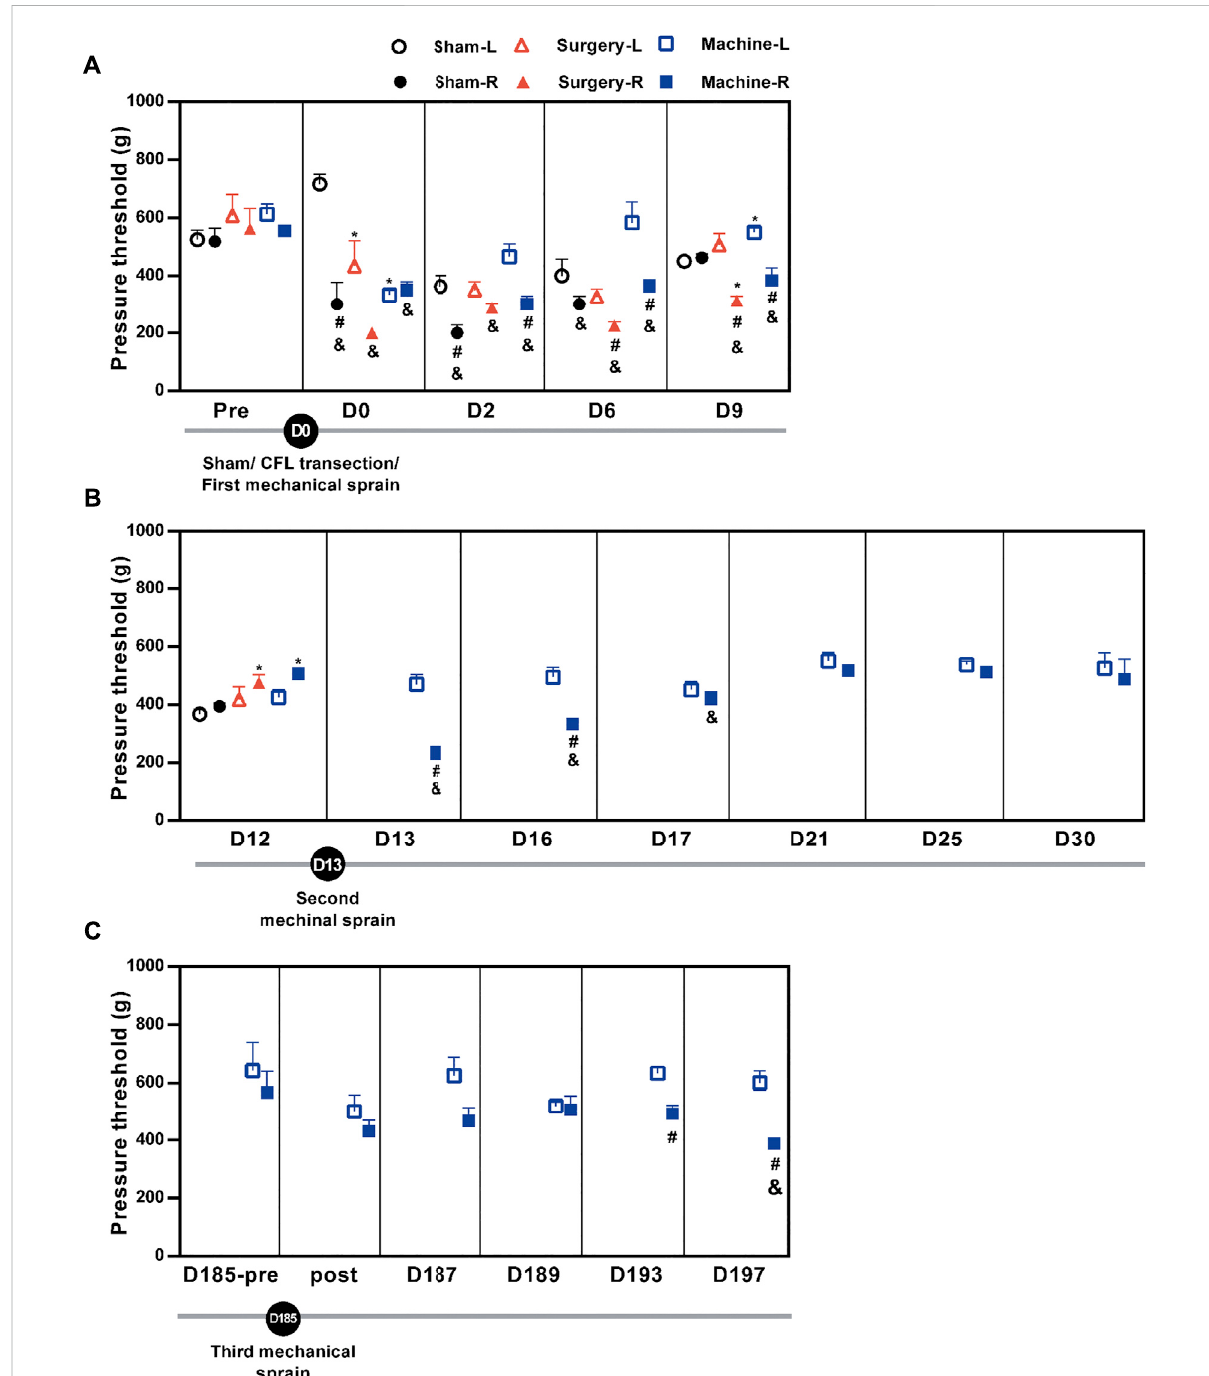
FIGURE 2 Changesinthepressurepain threshold after mechanicalankle sprains.Theankle pain threshold wasmeasuredusing PAMontheindicated day. The pain threshold is shown (A) after the sham operation or the CFL transection or the fi rst mechanical ankle sprain on day 0 (D0), (B) after the second mechanical ankle sprain on the 13th day (D13), and (C) before (D185-pre) and after (post) the third mechanical ankle sprain on the 185th day(D185).Valuesaremean±SEM, n =4.Thestatisticalsigni fi cancewasanalyzedusingpaired t testwithinthegroup(#and & )orunpaired t test between groups (*). * p < 0.05 compared with corresponding sham group; # p < 0.05 compared with corresponding left untreated foot (L); & p < 0.05 compared with the corresponding right treated foot (R) of pretreatment (pre) baseline on the 12th day (D12) in (B) and pretreatment baseline on the 185th day (D185-pre) in (C)